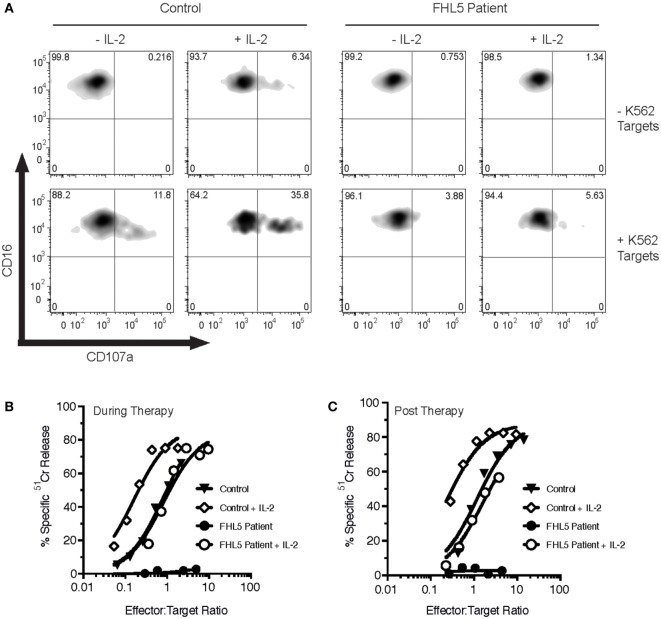
Bi-allelic mutations in STXBP2 impair natural killer (NK) degranulation and cytotoxicity, which is partially restored by IL-2. Peripheral blood mononuclear cells (PBMCs) were isolated from a healthy donor control (Control) and an FHL5 patient and incubated for 16 h in the absence (-IL-2) or presence (+IL-2) of 100 U/mL of human IL-2. (A) PBMCs were incubated for 3 h in the absence (−K562) or presence (+ K652) of K562 target cells. NK degranulation was assessed by measurement of CD107a surface labeling in the CD16+ cell populations. Data are representative of two independent experiments. (B,C) PBMCs taken during therapy (B) or after therapy (C) were incubated with 51Cr-labeled K562 target cells for 4 h at the indicated effector to target cell ratios (normalized for the% of NK cells). NK cytotoxicity was determined by the release of 51Cr from target cells. Data are representative of two independent experiments.